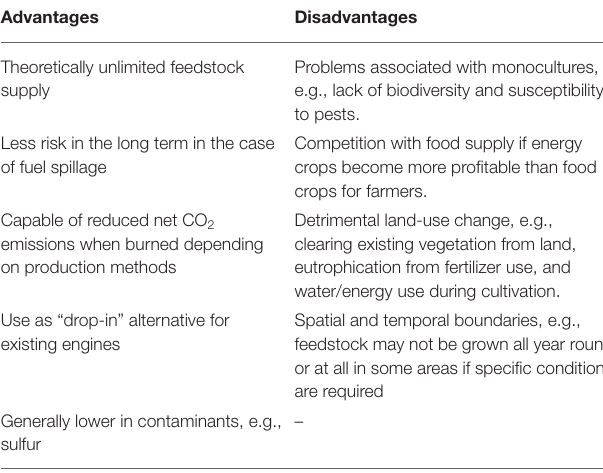
TABLE 2 | Advantages and disadvantages of bio-aviation fuel (Rye et al., 2010; Hendricks et al., 2011; Gegg et al., 2014; Bosch et al., 2017; de Jong et al.,